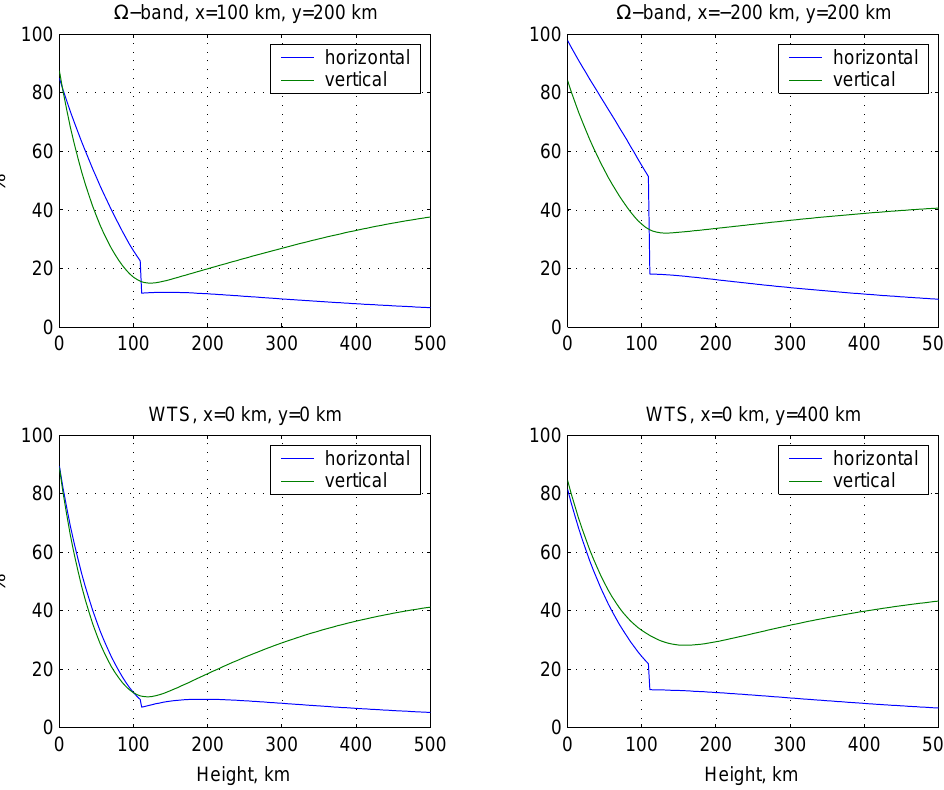
Fig. 10. Height profiles of the ratio secondary/primary magnetic field (horizontal and vertical components) at different locations of the WTS and (cid:127) -band models. The upper left panel corresponds to Fig.